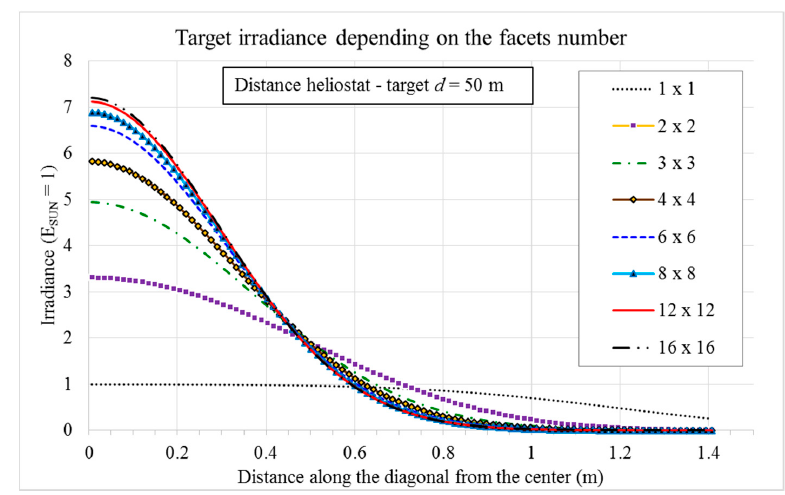
Figure 7. Irradiance E ( x , y ) on the target for faceted mirrors.